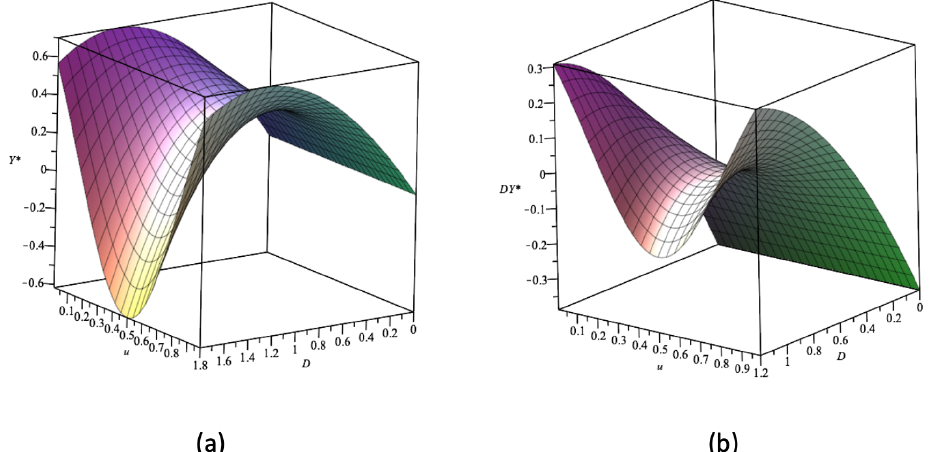
Figure 10. ( a ) Yield Y ∗ ( u , D ) at equilibrium for system of coupled rearing basins with respect to u and D . ( b ) Excess Yield ∆ Y ∗ ( u , D ) at equilibrium for system of coupled rearing basins with respect to u and D . Parameters set: s in = 0.5, µ = 8.5 and k = 2.5.